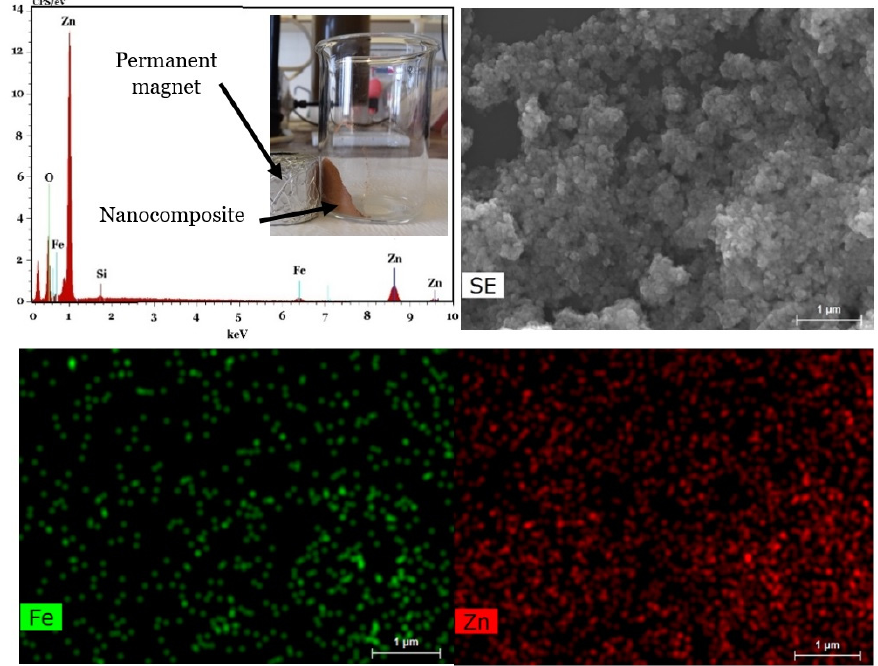
Figure 4. EDS and mapping indexes for Fe and Zn of the sample obtained from the same SEM profile of ZnO/ γ -Fe 2 O 3 /Bentonite.